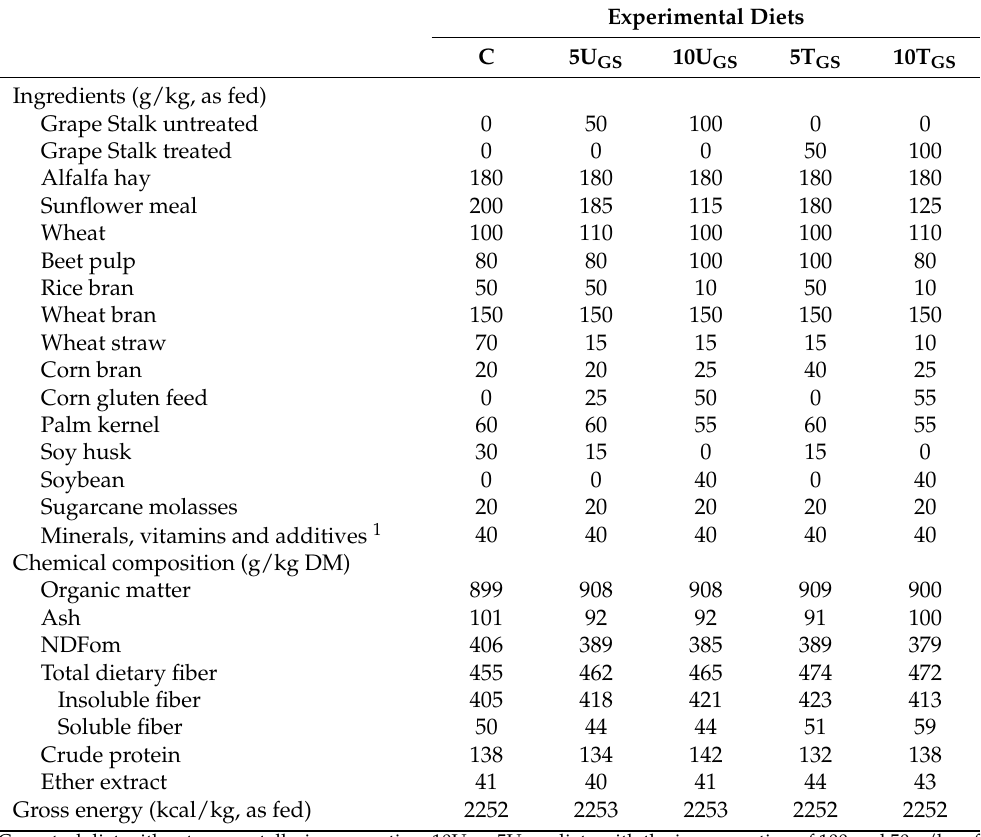
Table 1. Ingredients (g/kg, as fed) and chemical composition (g/Kg, as fed) of the five experimental